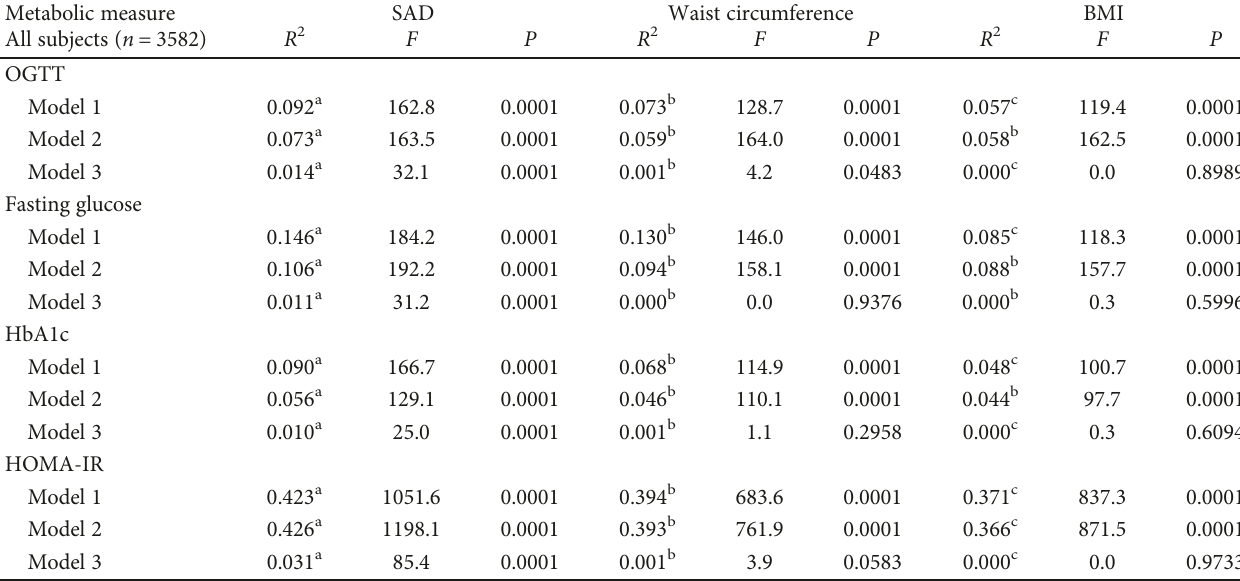
Table 2: Shared variance between the anthropometric variables and the glucose metabolism variables. Metabolic measure